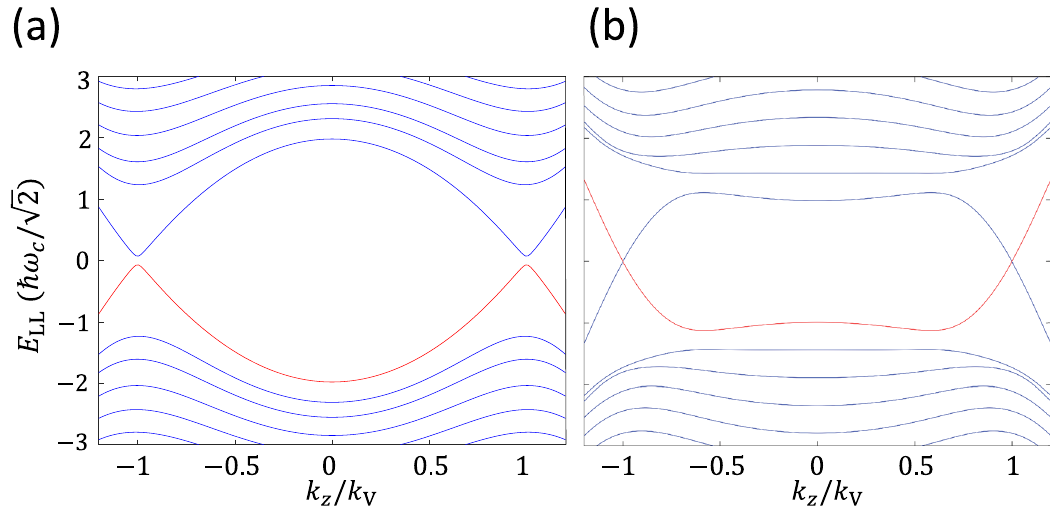
Figure 2. The Laudau band spectrum with respect k z / k V for two pairs of Weyl nodes separated in the k z k V , respectively. ( a ) for Model A and ( b ) for Model B. In both ( a ) and ( b ), g direction at k z = ± 0.2 so that A 0.5 , and k V / v x v z k W = = �